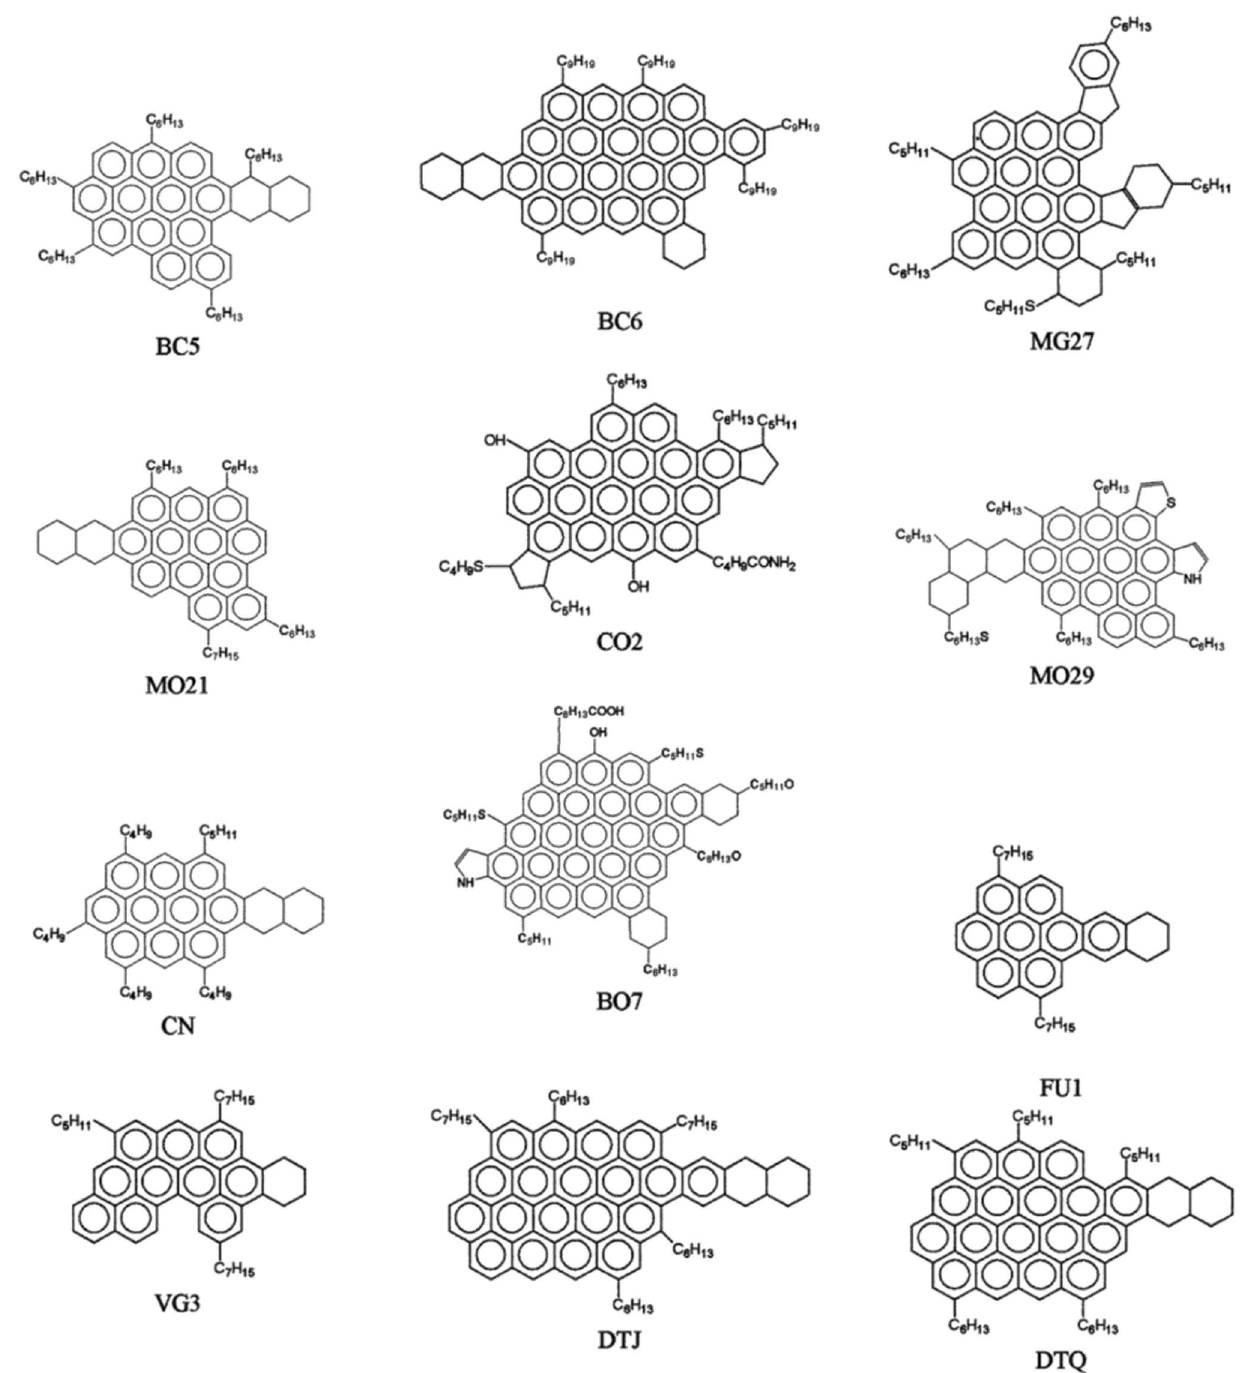
Fig. 1 Asphaltene samples’ average